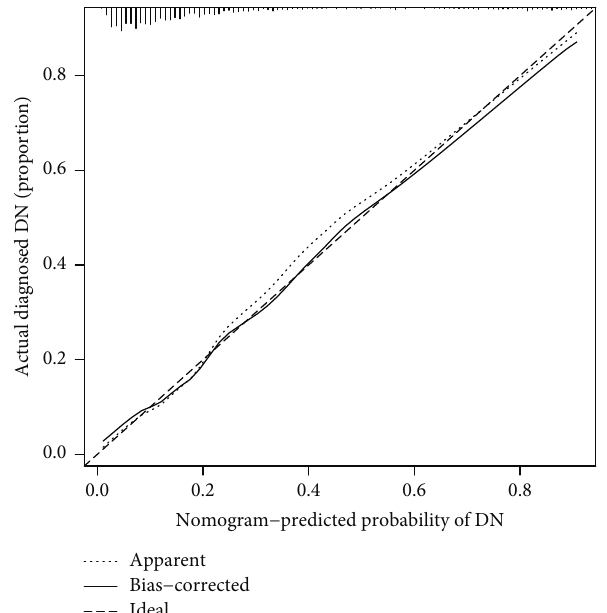
Figure 4: Calibration curves of the DN risk nomogram prediction. The diagonal dotted line meant a perfect prediction by an ideal model while the solid line represented the performance of the nomogram. A closer fit to the diagonal dotted line meant a better prediction.